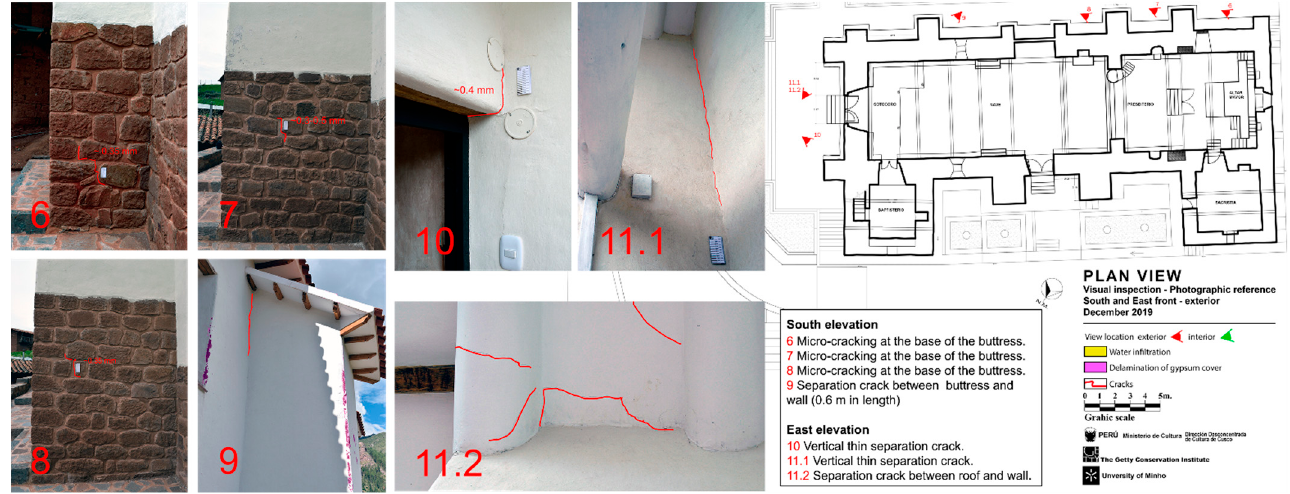
Figure 8. Set of documented damages comprised of thin cracks, at wall intersections and the base course of the new buttresses. Note the photo references in the plan view.